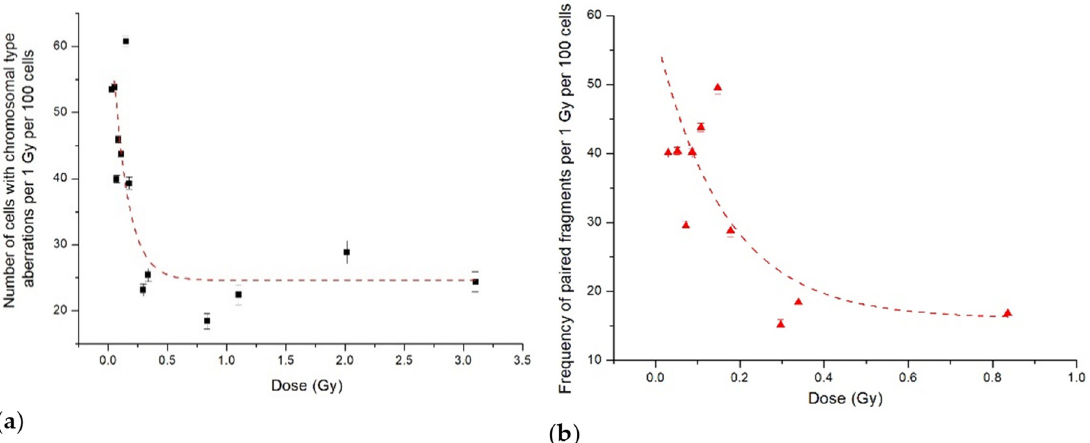
Figure 4. The data from Figure 3 normalised per dose: ( a ) number of CHO-K1 cells with aberrations of chromosomal type; ( b ) frequency of paired fragments. Symbols are the experimental data, and lines show our fits to the IR model.